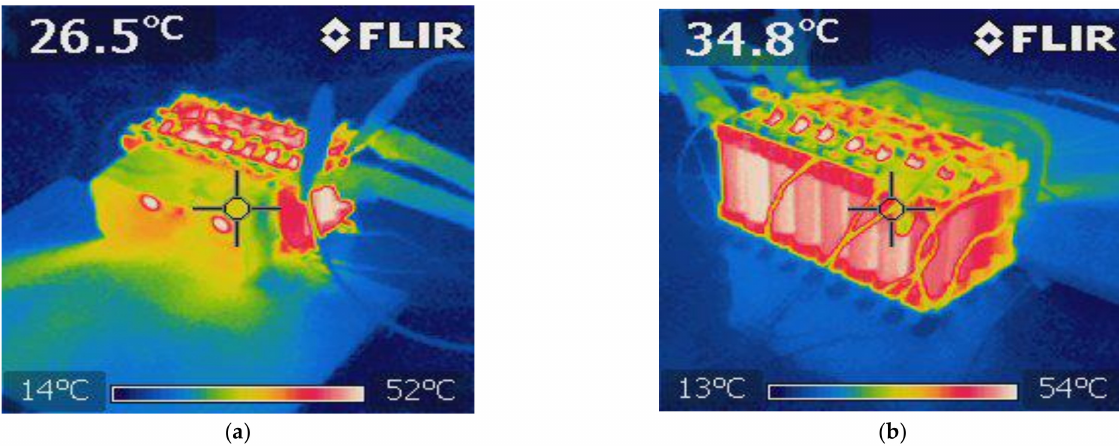
Figure 22. Thermal images. ( a ) Front of module zero, 72 A discharge; ( b ) rear of module zero, 72 A